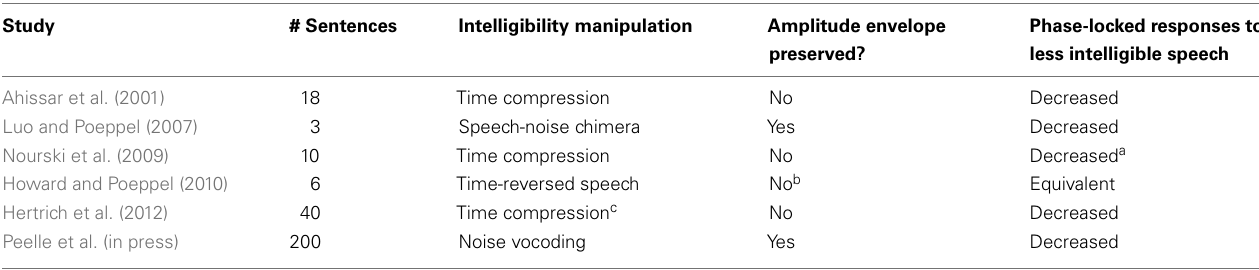
Table 1 | Studies examining the effect of intelligibility on the phase locking of cortical oscillations to the speech